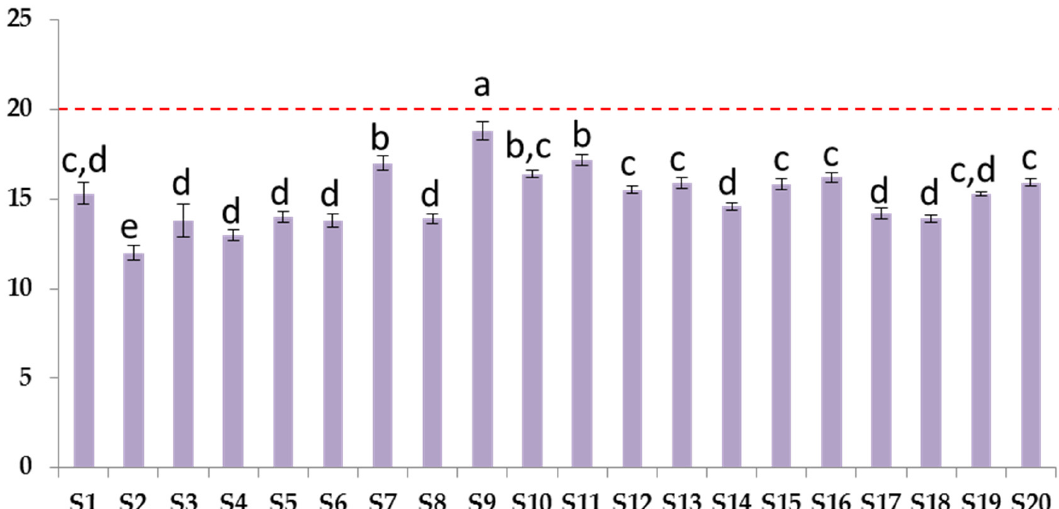
Figure 7. p -Anisidine values of supplements (red dotted line indicates the GOED maximum limit of 20). Error bars present the standard deviation ( n = 3). Different letters report the statis- tical differences ( p <